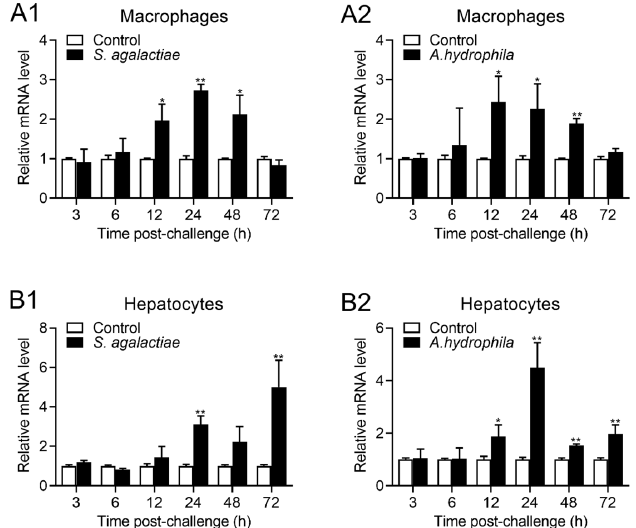
Figure 4. The expression pattern of OnTRAP5b in vitro. The mRNA expression of OnTRAP5b in head kidney macrophages ( A1 , A2 ) and the hepatocytes ( B1 , B2 ) after treatment with S. agalactiae (1 × 10 8 CFU/mL), A. hydrophila (1 × 10 8 CFU/mL) and a control group treated with PBS. The mRNA level of the OnTRAP5b gene was normalized to β -actin, and the fold units were calculated, deciding the value of the PBS-treated cells. The values are shown as means ± SD ( n = 3), n , the number of times the experiments were performed. ** p < 0.01, * p <